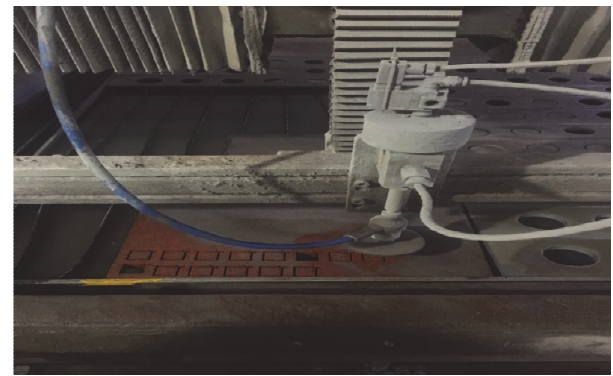
Fig. 3. Granite cutting using